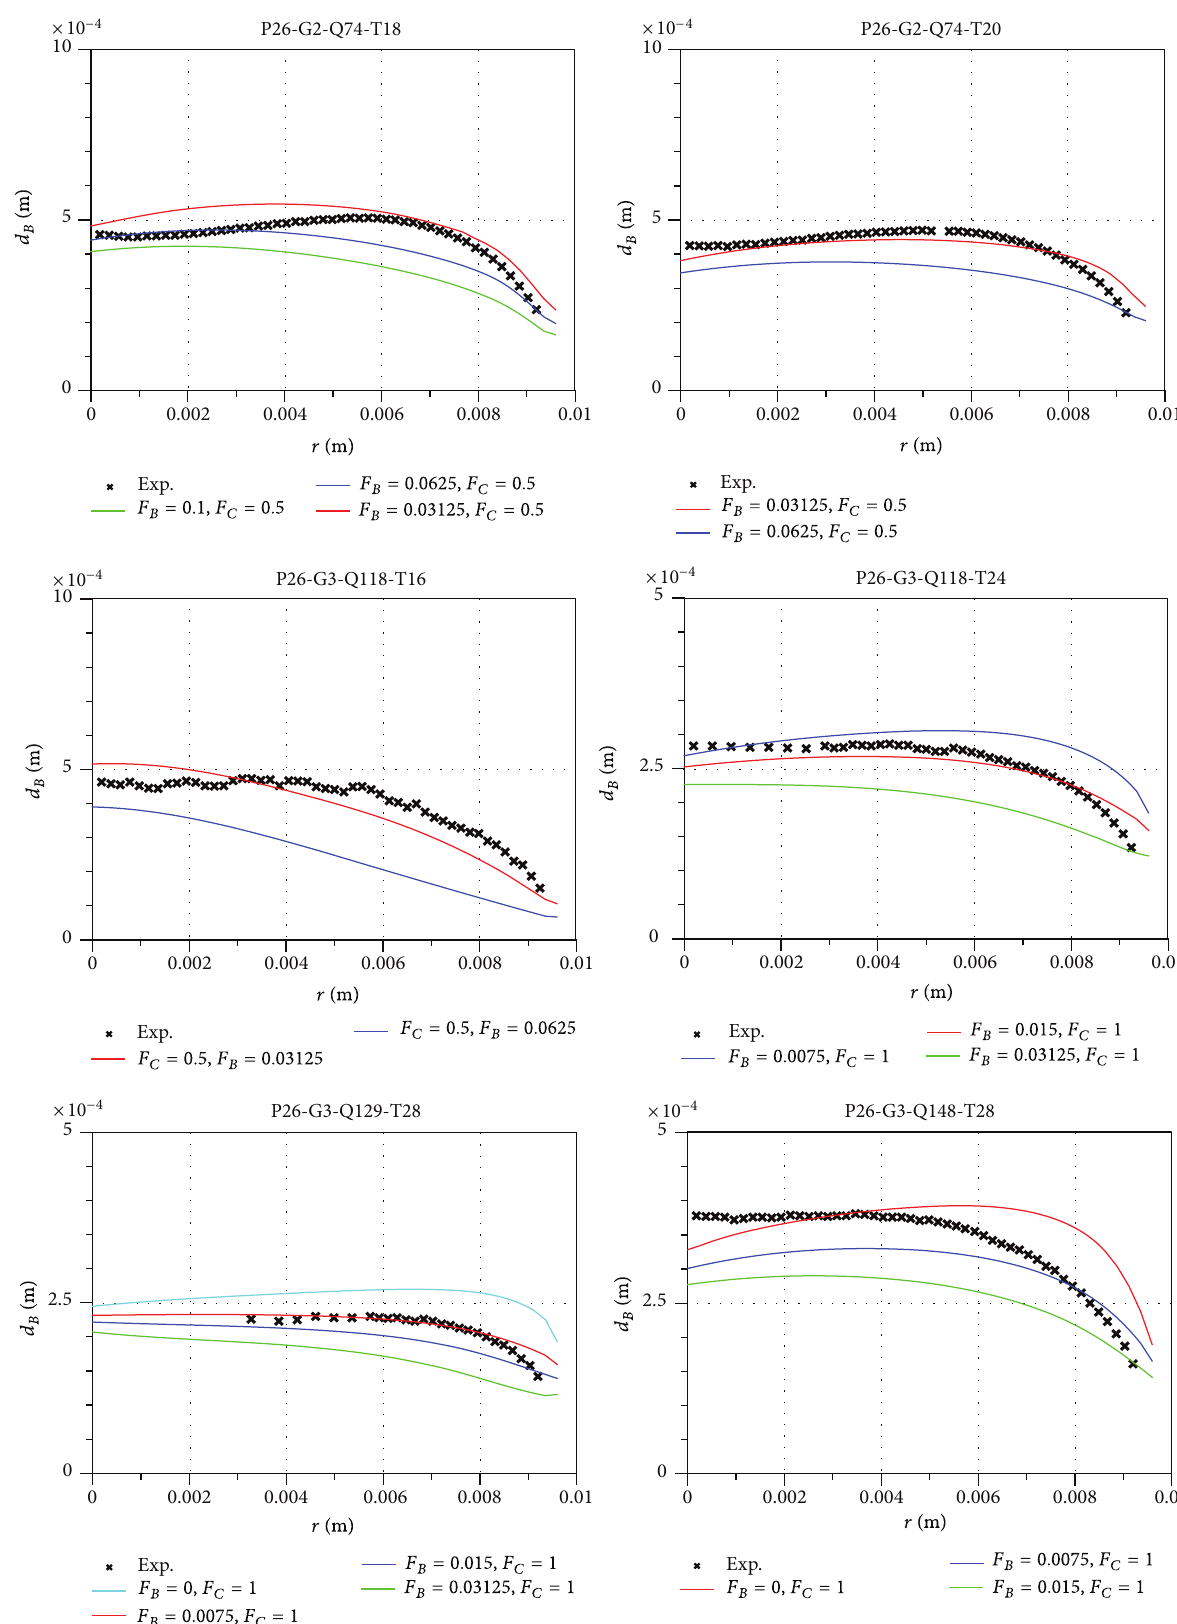
F 5: �adial �ro�les of �u��le si�e for di�erent